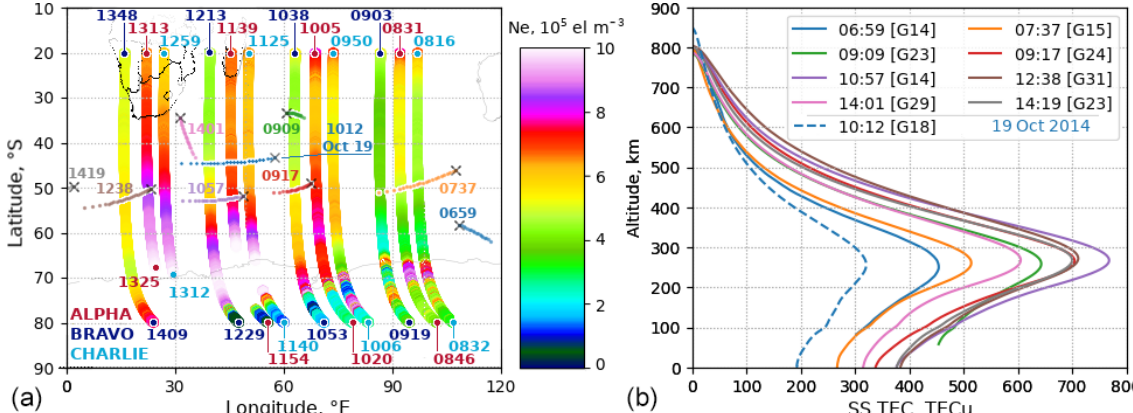
Figure 2. (a) The electron concentration from 08:00 to 14:00UT on 5 April 2014 measured by SWARM, and (b) the total electron content from RO measurements by COSMIC satellites (solid). (b) SS TEC profiles from 5 April compared with the profile from 19 October 2014 when no LTE was detected (dashed). The numbers represent the time of observation and are presented in the following format: HHMM (hours and